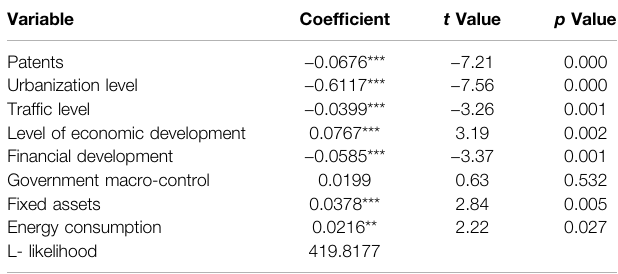
TABLE 7 | Regression results of the tobit